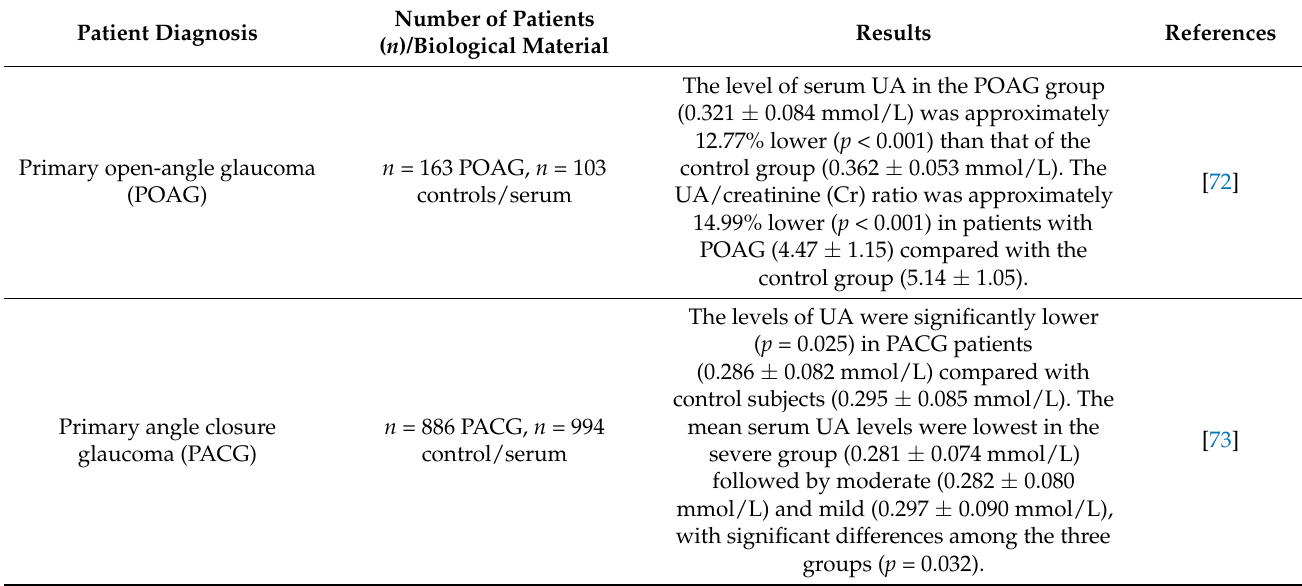
Table 5. Uric acid as a potential biomarker in